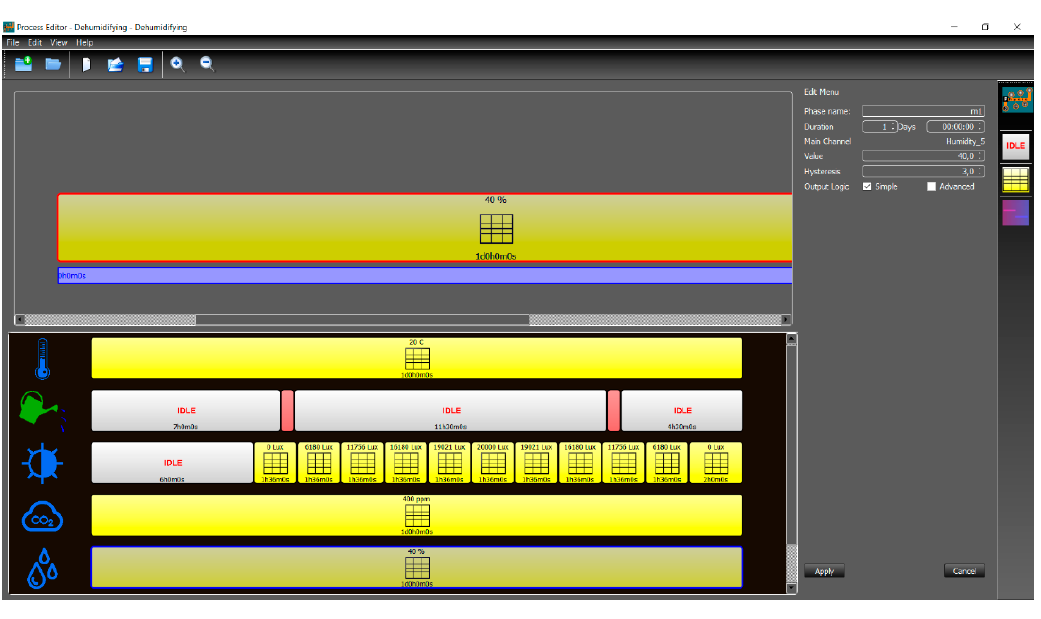
Figure 22. Process Editor interface.